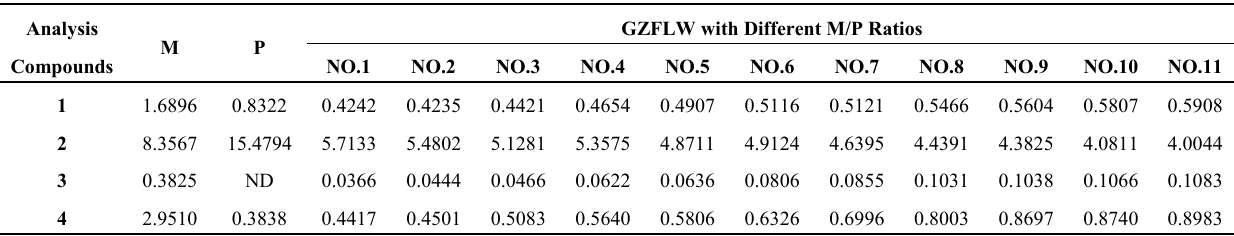
Table 4. Contents of 1 , 2 , 3 , 4 in M , P and GZFLW (mg/g).